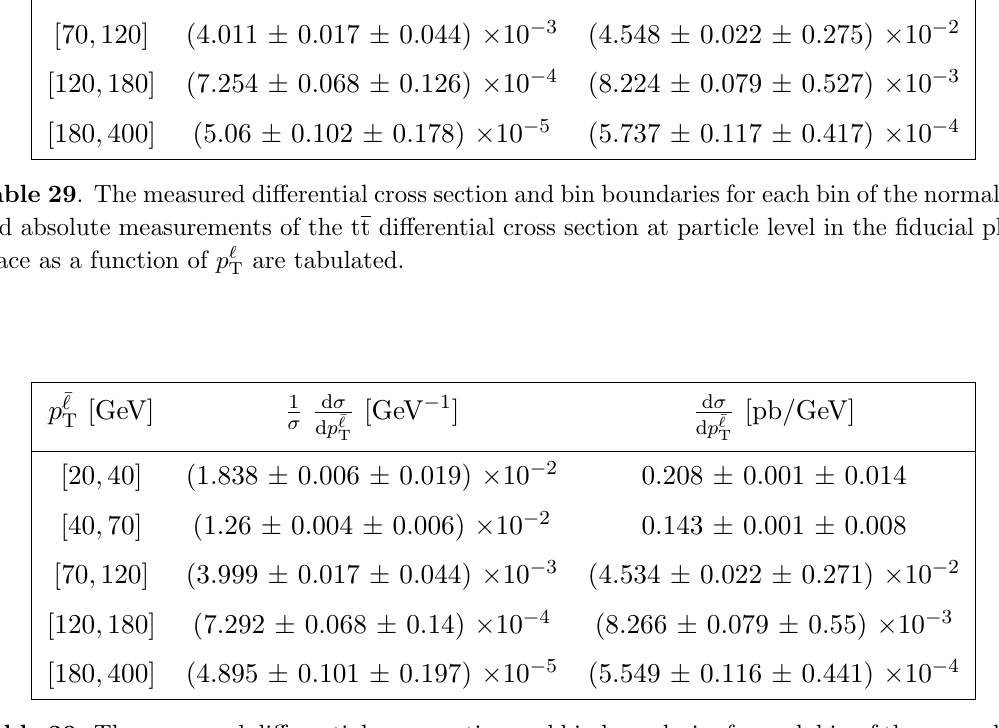
Table 30 . The measured di(cid:11)erential cross section and bin boundaries for each bin of the normalized and absolute measurements of the tt di(cid:11)erential cross section at particle level in the (cid:12)ducial phase space as a function of p (cid:22) ‘ are tabulated. T